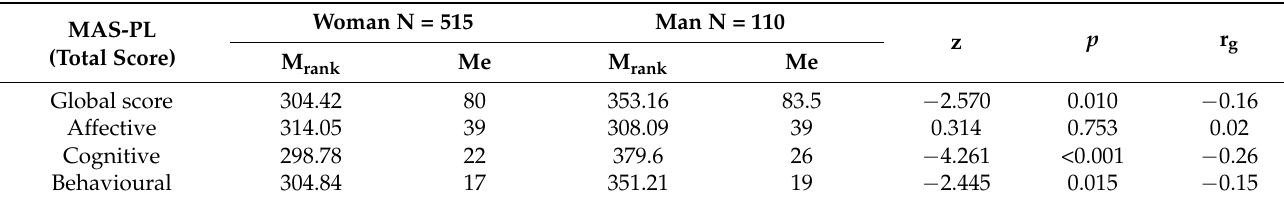
Table 3. Assumption of z tests of the results of MAS-PL scores (total score, affective, cognitive, and behavioural subscales) by gender (N =